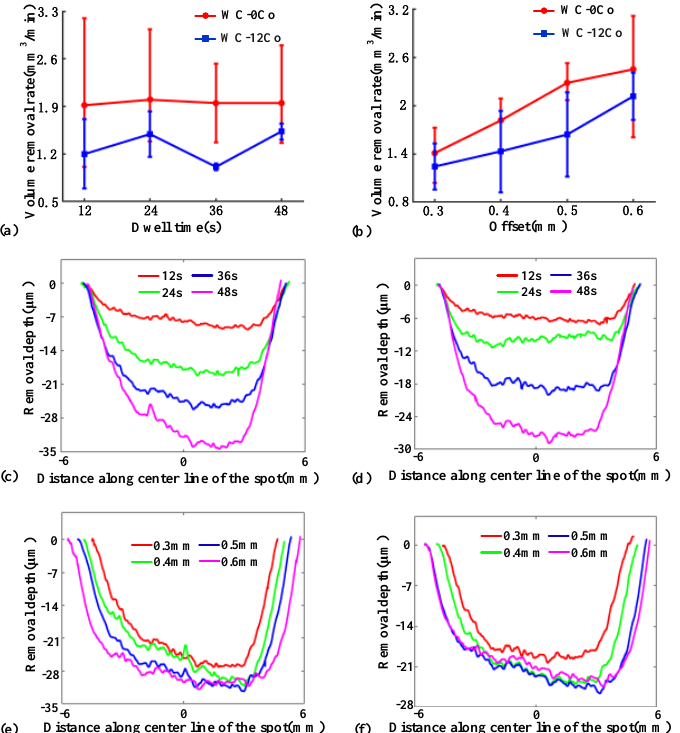
Figure 2. Analysis of TIFs on WC-0Co and WC-12Co under different conditions. ( a ) VRR analysis under different dwell times; ( b ) VRR analysis under different dwell times; ( c ) section profile of TIF on WC-0Co with different dwell times; ( d ) section profile of TIFs on WC-12Co with different dwell times; ( e ) section profile of TIFs on WC-0Co with different tool offsets; ( f ) section profile of TIFs on WC-12Co with different tool offsets.